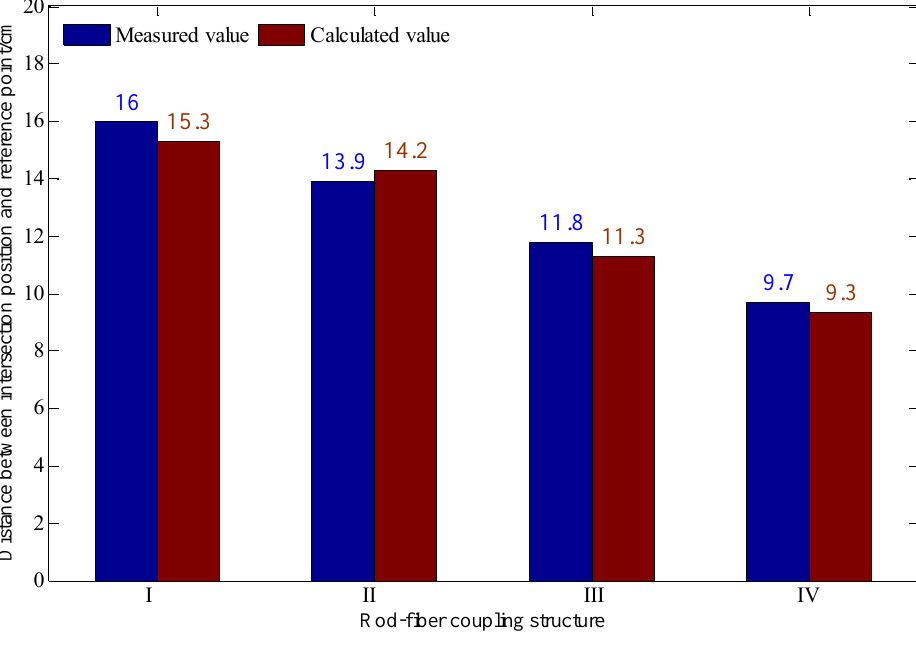
Figure 17. The distance between the intersection position of the rod-fiber coupling structure and sliding surface and the reference point.